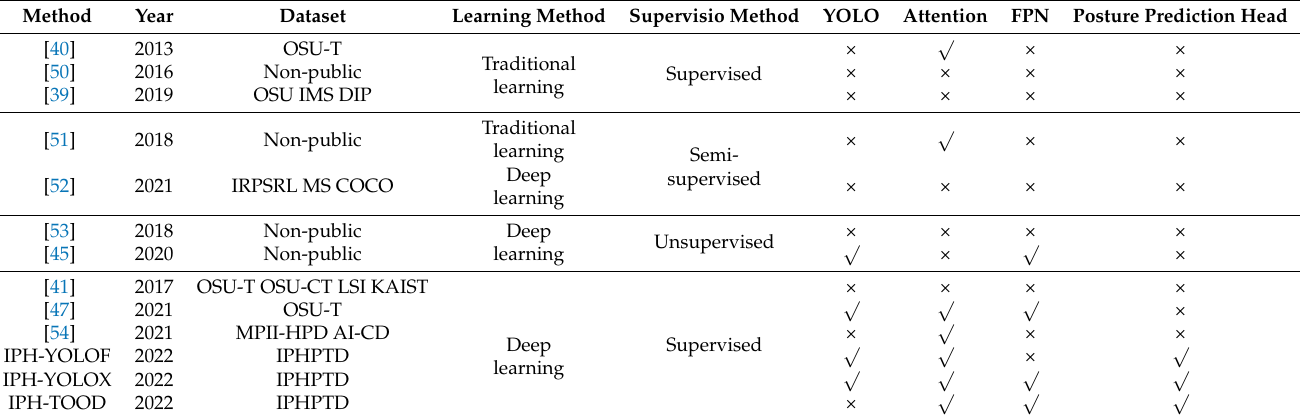
Table 1. Comparison of advantages and disadvantages of our methods (i.e., IPH-YOLOF, IPH- YOLOX, and IPH-TOOD) with previous